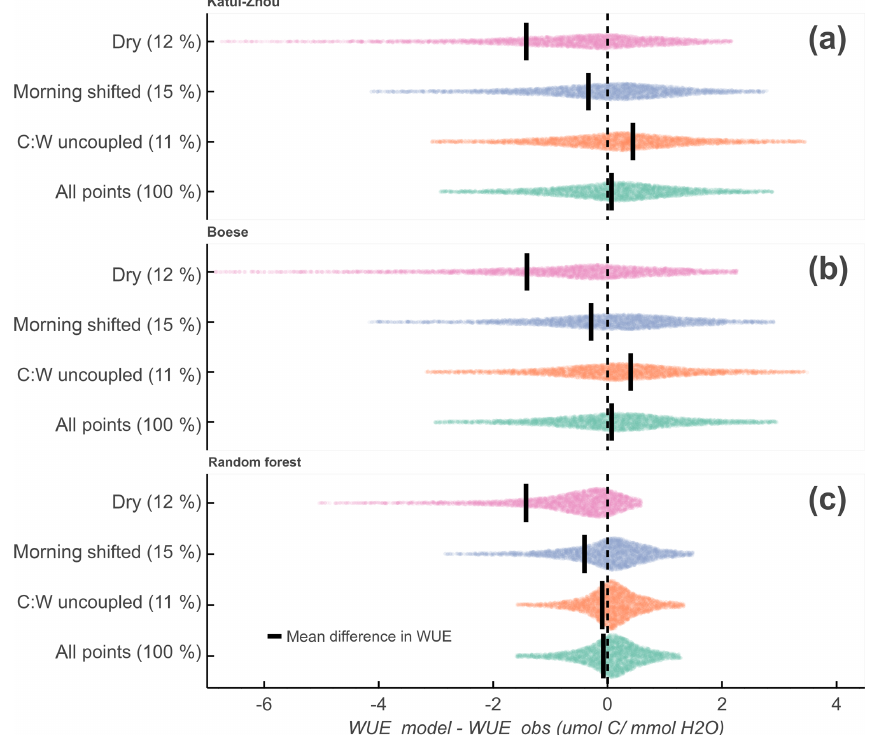
Figure 7. Difference in modeled and measured WUE for Katul–Zhou (a) , Boese (b) , and random forest (c) models. The random forest model was fit using R g , VPD, T air , GPP, and year. Thresholds designating dry, morning-shifted, and carbon–water uncoupled days were EF<0.2, C ∗ < − 0.25, and DWCI<25, respectively, for each day. The distributions span from the 5th to 95th percentiles, and the width of each gives ET an indication of the variance, which is larger in the subgroups compared to all points. Furthermore, the mean difference in WUE (black lines) tends to be shifted in dry and morning-shifted days, indicating a mean underestimation of WUE by the models mostly due to the long tails. Decoupled days show higher variance but no clear pattern in under- or overestimation. The percentage of days in each category is designated in parentheses next to the y axis label